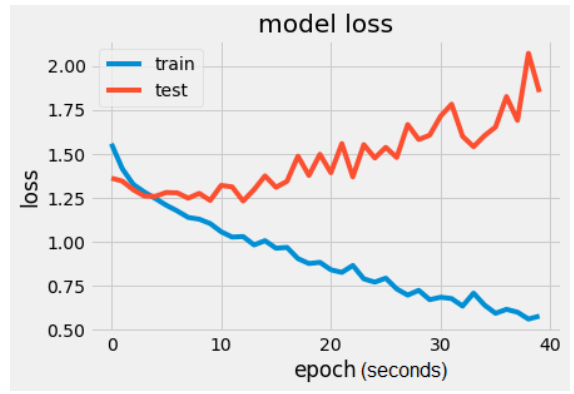
Figure 5. VGG16 model loss.